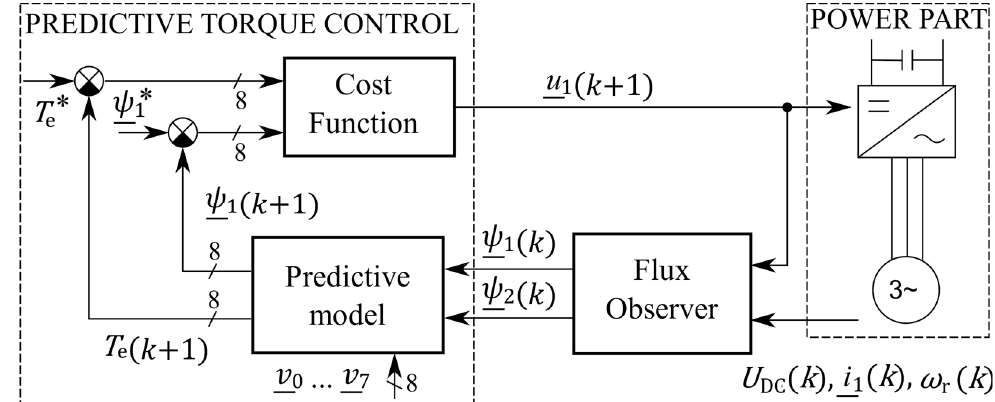
Figure 5. Basic block diagram of the induction motor predictive torque control.